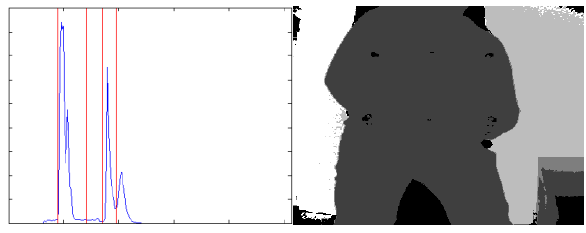
Figure 9. Left: histogram of the depth values of Fig. 8 (blue) with calculated thresholds (red). Right: Fig. 8 transferred to discrete depth layers.